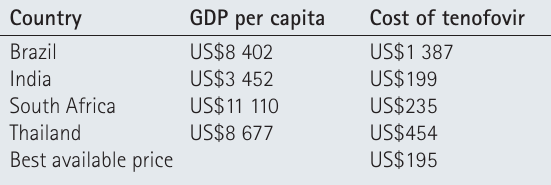
TAbLE I. COMPARISON OF TDF PRICES IN SELECTED DEVELOPING COuNTRIES, 2007